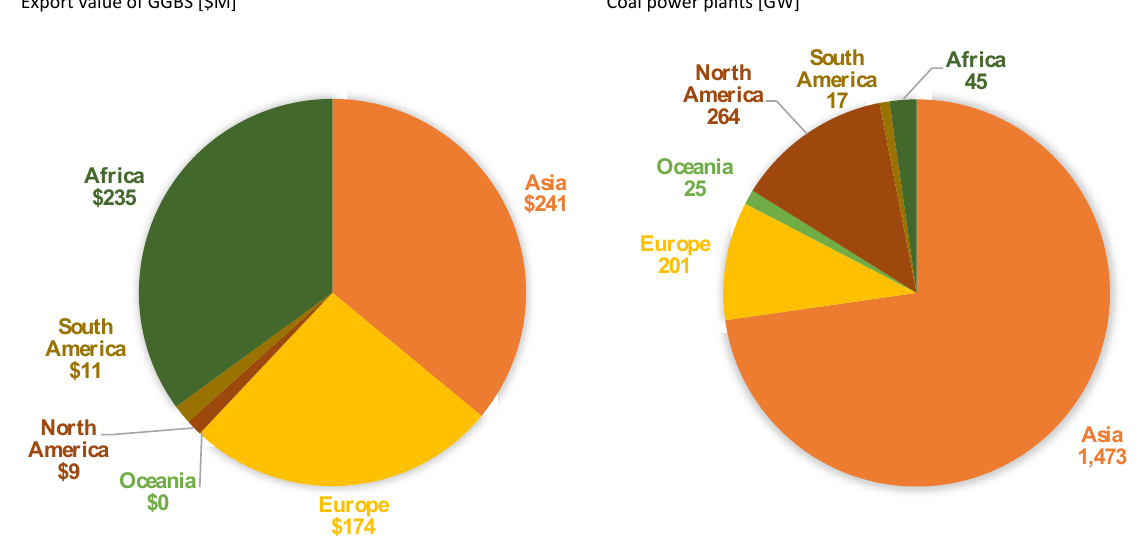
Fig. 2. Pie chart displaying the availability of GGBS and FA per continent (data from Figure 1 summarized by continent).